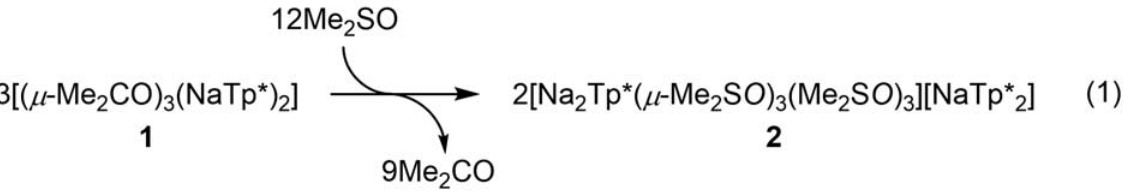
Figure 3: Time evolution of the 1 H NMR spectrum of 1 recorded in DMSO- d room